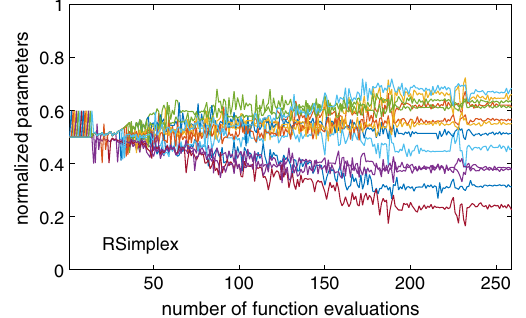
FIG. 3. Variation of the 13 skew quadrupole current set points (normalized to the range [0, 1]) for the coupling correction experi- ment using the RSimplex algorithm (w/o simplex rebuilding).